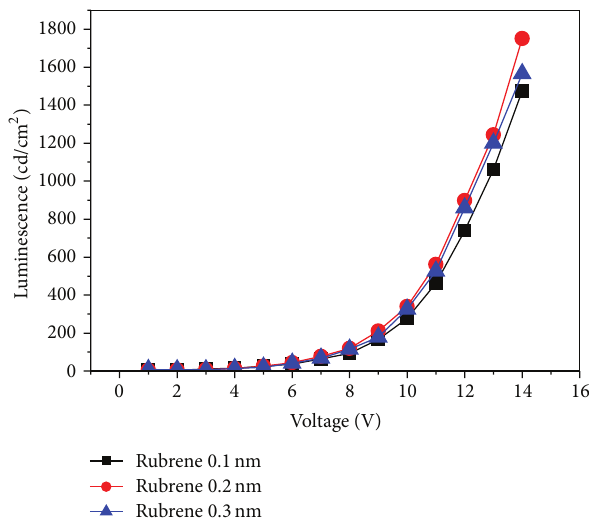
Figure 3: The luminance-voltage curves of the devices with various thicknesses of Rubrene layer.